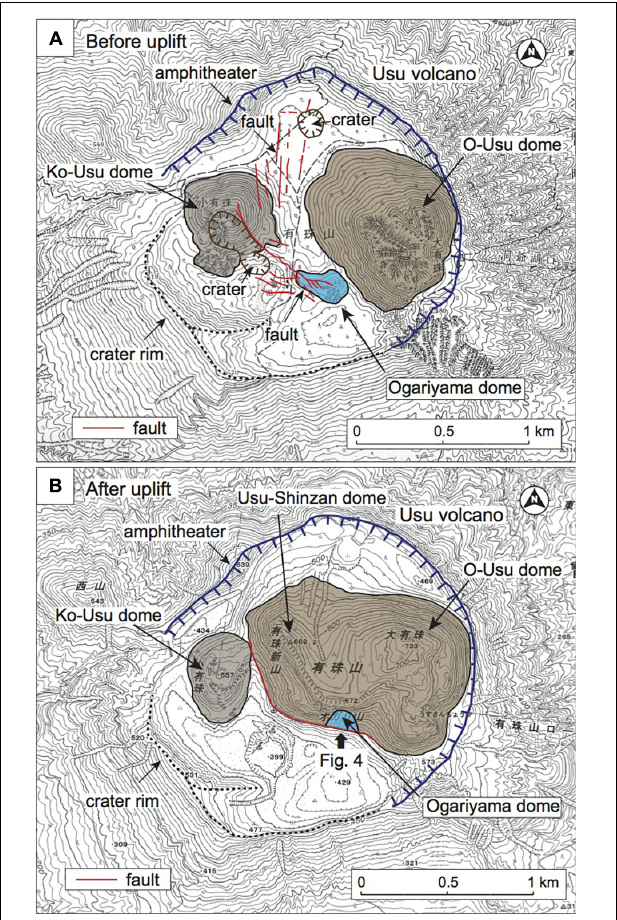
FIGURE 3 | (A) Topographic map of the summit area of Usu volcano before the 1977–1978 eruption, showing the location and shape of the Ogariyama dome before uplift. The Ogariyama dome is a small mound on the amphitheater floor. The base map was taken from a 1:25,000 scale topographic map issued in 1975 by the Geospatial Information Authority of Japan. Faults observed on 12 August 1977 (red lines) and craters that formed during the 1977 eruption (Katsui et al., 1985) are also shown. Note that the Ogariyama dome is cut by a fault. (B) Topographic map of the summit area of Usu volcano after the 1977–1978 eruption. The Ogariyama dome was cut by the fault, and its northern part was uplifted by the growth of the Usu-Shinzan cryptodome. The base map was taken from a 1:25,000 scale topographic map issued in 2008 by the Geospatial Information Authority of Japan.